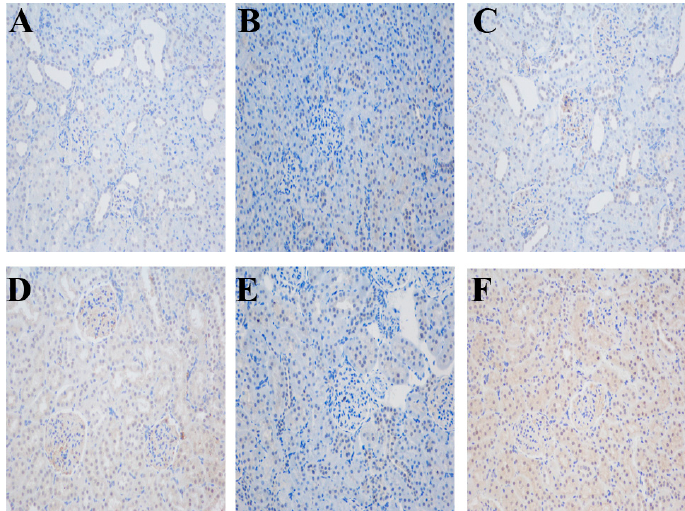
Figure 1. Immunohistochemical staining of estrogen-related receptor α (ERR α ) in rat kidney tissues (original magnification ×200). ( A ) BN (SS.13BN + Normal diet) group; ( B ) BH (SS.13BN + High salt diet) group; ( C ) BHD (SS.13BN + High salt diet + Daidzein) group; ( D ) SN (SS + Normal diet) group; ( E ) SH (SS + High salt diet) group; and ( F ) SHD (SS + High salt diet + Daidzein) group. Nuclei were stained blue with Hematoxylin, and diaminobenzidine (DAB) was brown.